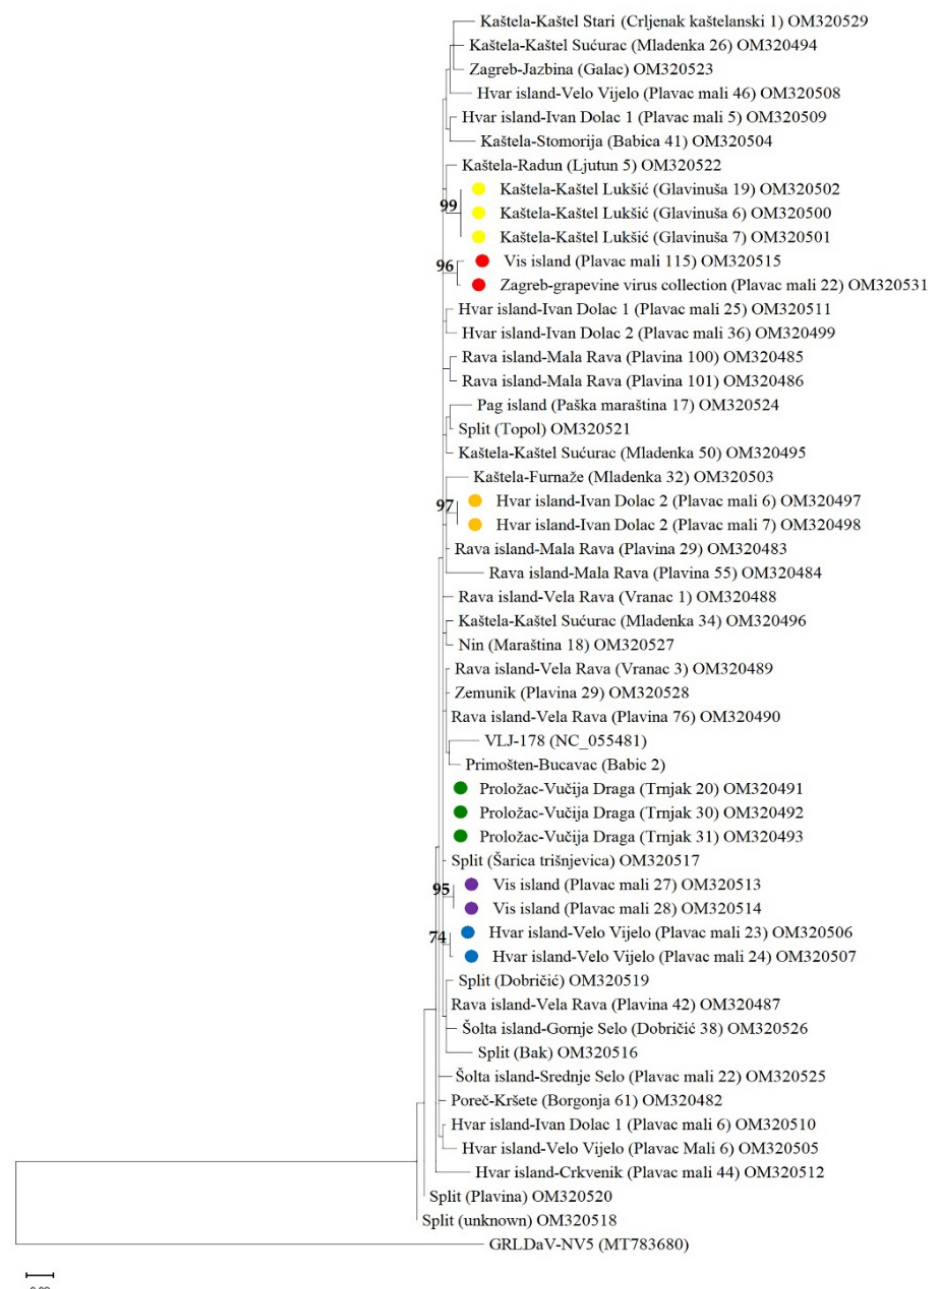
Figure 4. Maximum Likelihood (ML) tree showing phylogenetic relationships based on a 375 nts long sequences of the reverse transcriptase (RT) coding region of 50 newly discovered GBV-1 isolates, the reference isolate VLJ-178 and the grapevine Roditis leaf discoloration-associated virus (GRLDaV) isolate NV5 (MT783680) as a rooting outgroup. The tree was constructed using MEGA11 with the Tamura 3-parameter + gamma distribution (T3 + G) model of nucleotide substitution. Isolates were named according to the region, location of the vineyard, cultivar and exact vine/sample. Isolates marked with colored dots are collected from the same vineyard/collection and are represented on branches with a support greater than